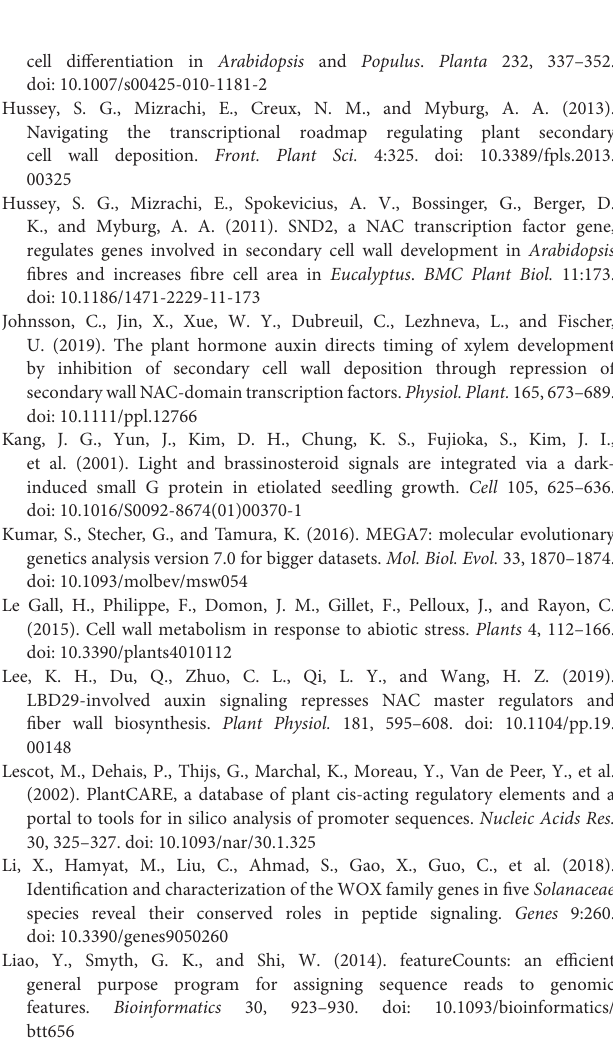
Supplementary Table 6 | Specific primers for transactivation activity assay. Supplementary Table 7 | Statistical differential expression analysis of 15 NtSWNs between treatments and